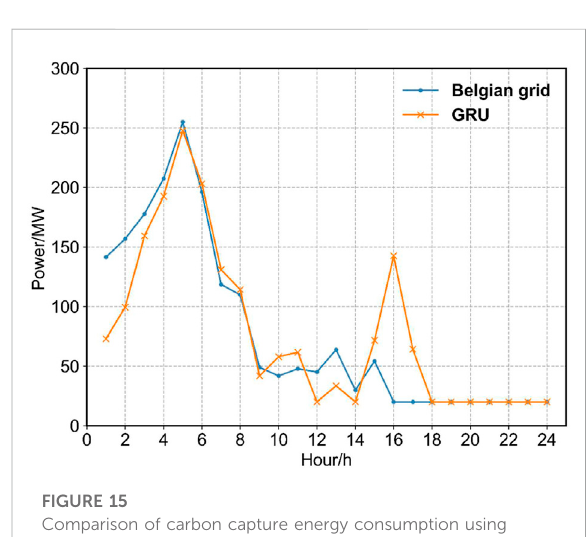
FIGURE 15 Comparison of carbon capture energy consumption using different forecast wind power in day-ahead